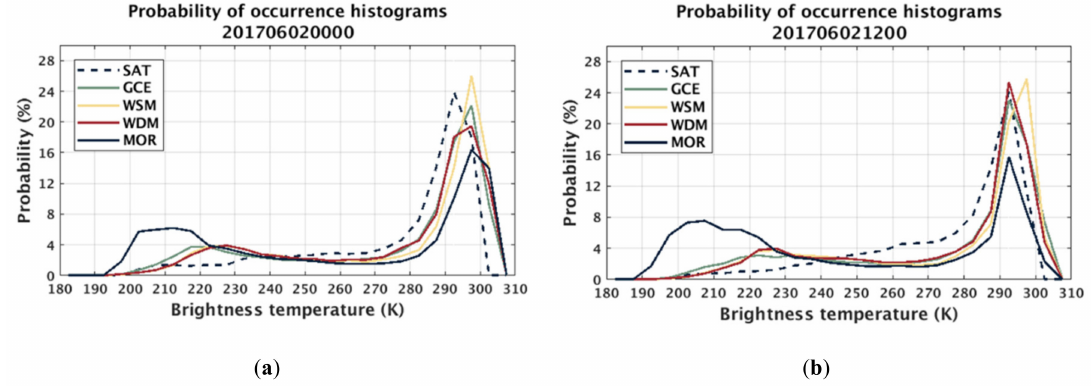
Figure 7. Domain 02 BT 10.4 µ m probability of occurrence valid on 2 June 2017 at ( a ) 0000 and ( b ) 1200 UTC.